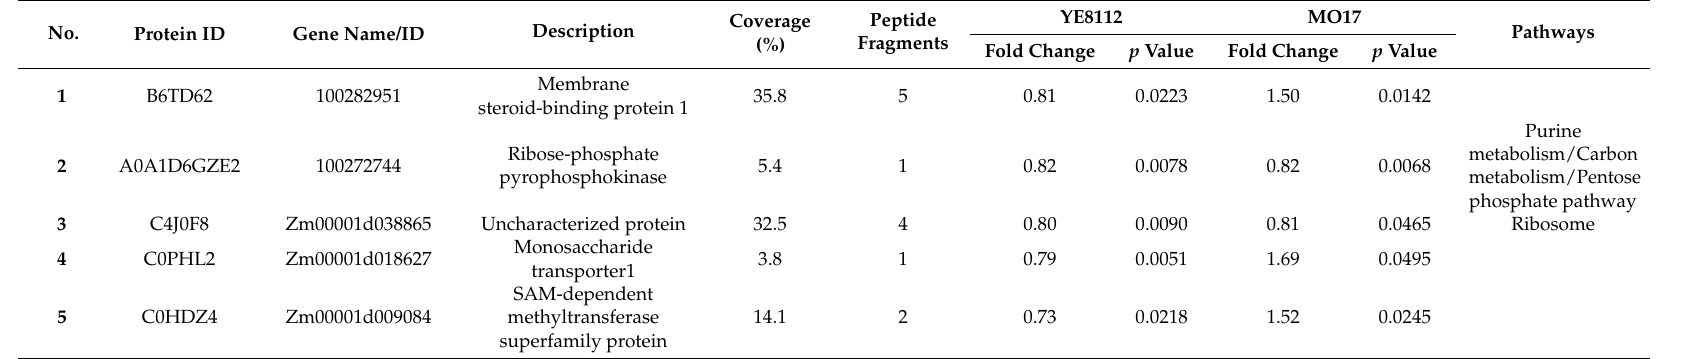
Table 5. Common (overlapping) drought-responsive seedling leaf DAPs between MO17 and